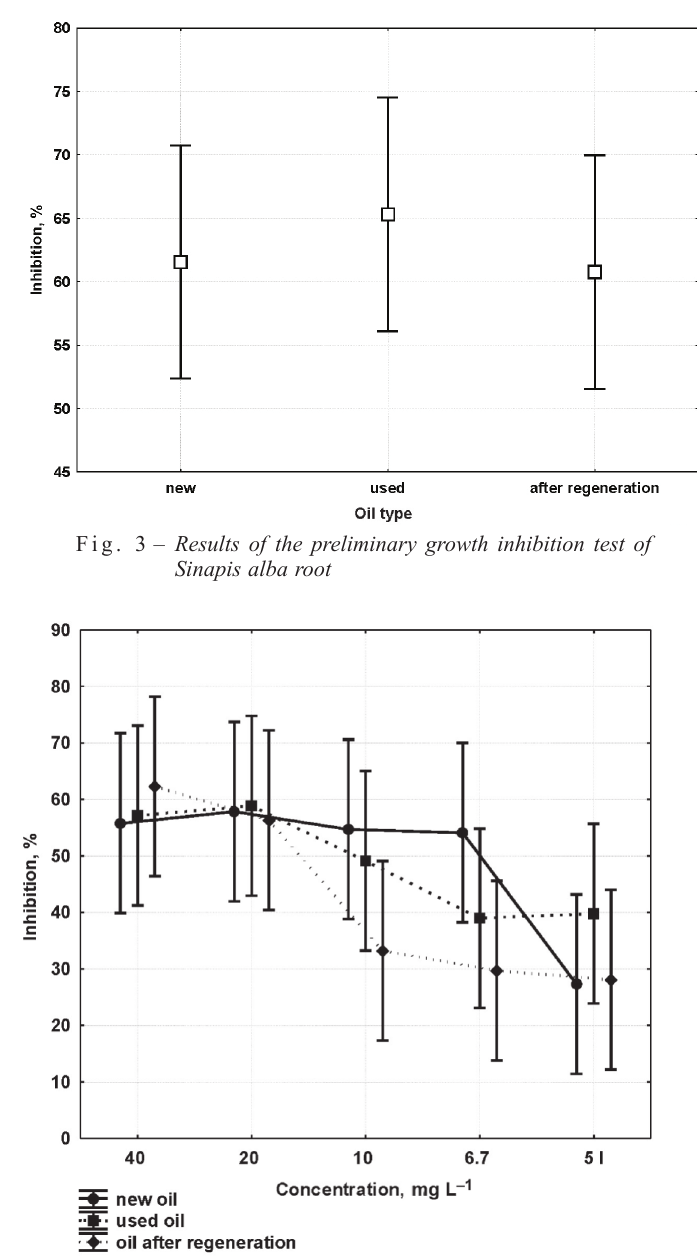
Fig. 4 – Dependence of % inhibition and concentration for each type of